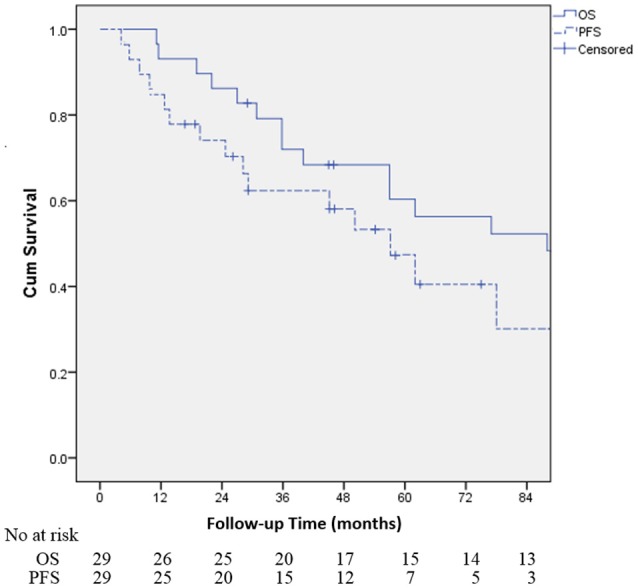
Kaplan-Meier curves for the cohort illustrating for overall survival (OS) and progression-free survival (PFS).